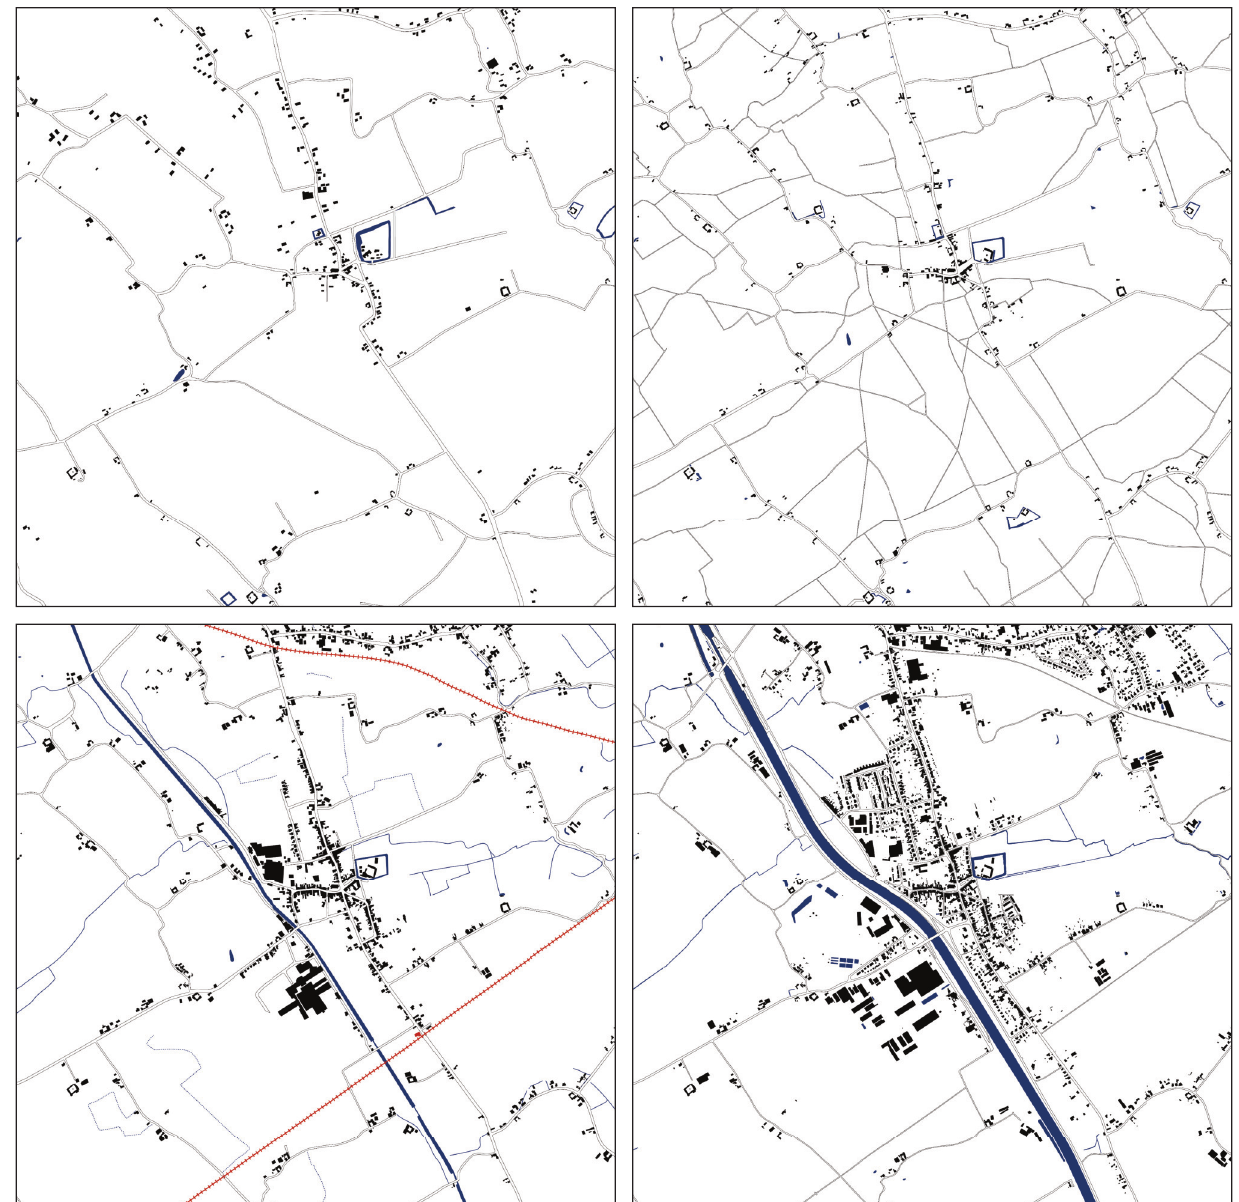
Figure 6. The presence of the moated farmstead Goed te Mouden and the church in Moen were important elements for the increasing urbanisation of the village. Sources: Sophie Leemans’ work based on the de Ferraris 1771 map (top left; Geopunt Vlaanderen, n.d.‐a), Popp map (top right; Geopunt Vlaanderen, n.d.‐c), aerial picture (bottom left; Geopunt Vlaanderen, n.d.‐d), aerial picture (bottom right; Geopunt Vlaanderen, n.d.‐e). Urban Planning, 2023, Volume 8, Issue 1, Pages